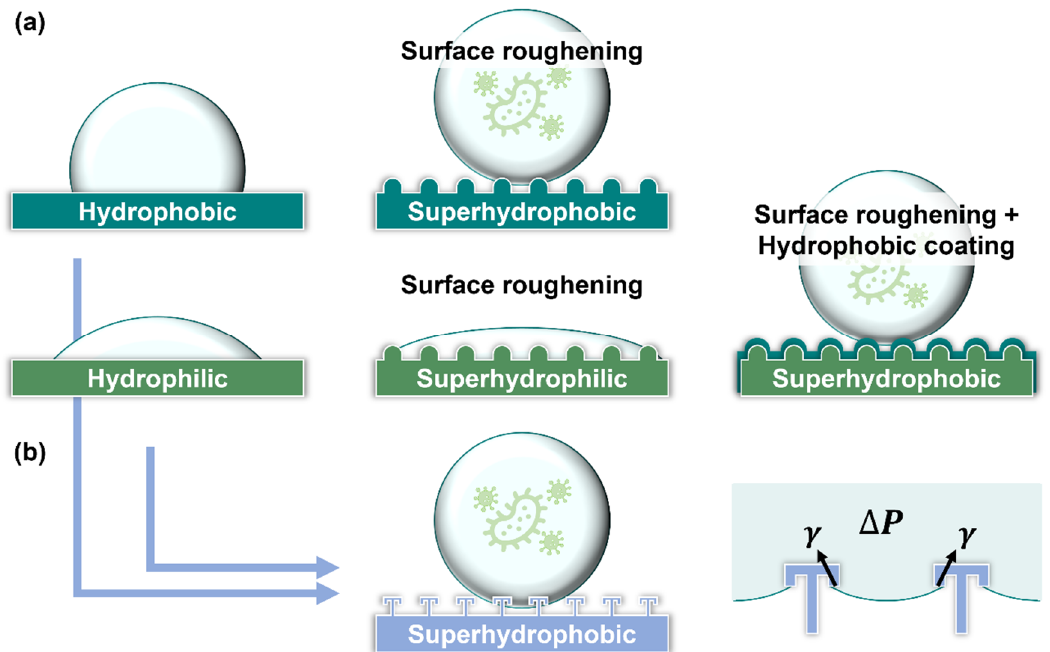
Figure 4. Approaches to obtaining superhydrophobic surfaces ( a ) Superhydrophobic methods, such as roughening hydrophobic surface or hydrophobic coating to a rough surface. ( b ) DRT structures provide upward surface tension for droplet suspension even on highly wetted materials, which have mechano-superhydrophobic and anti-biofouling characteristics.